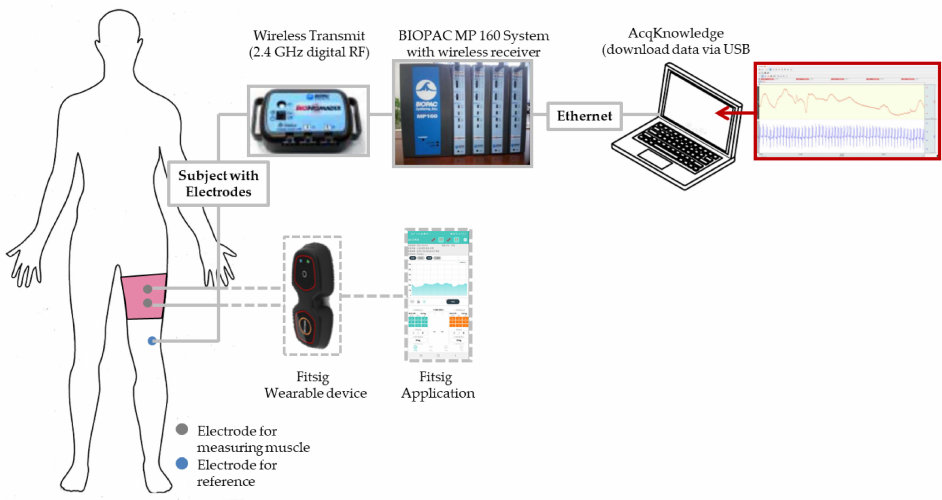
Figure 2. Schematic diagram of the measuring process for the sEMG